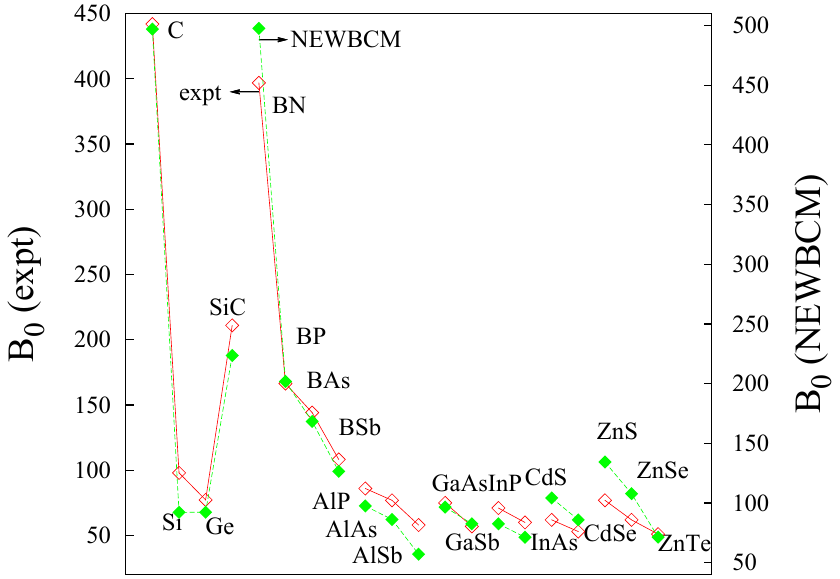
Figure 3. Experimental vs . non empirical new bond charge model (NEWBCM) bulk modulus (GPa).